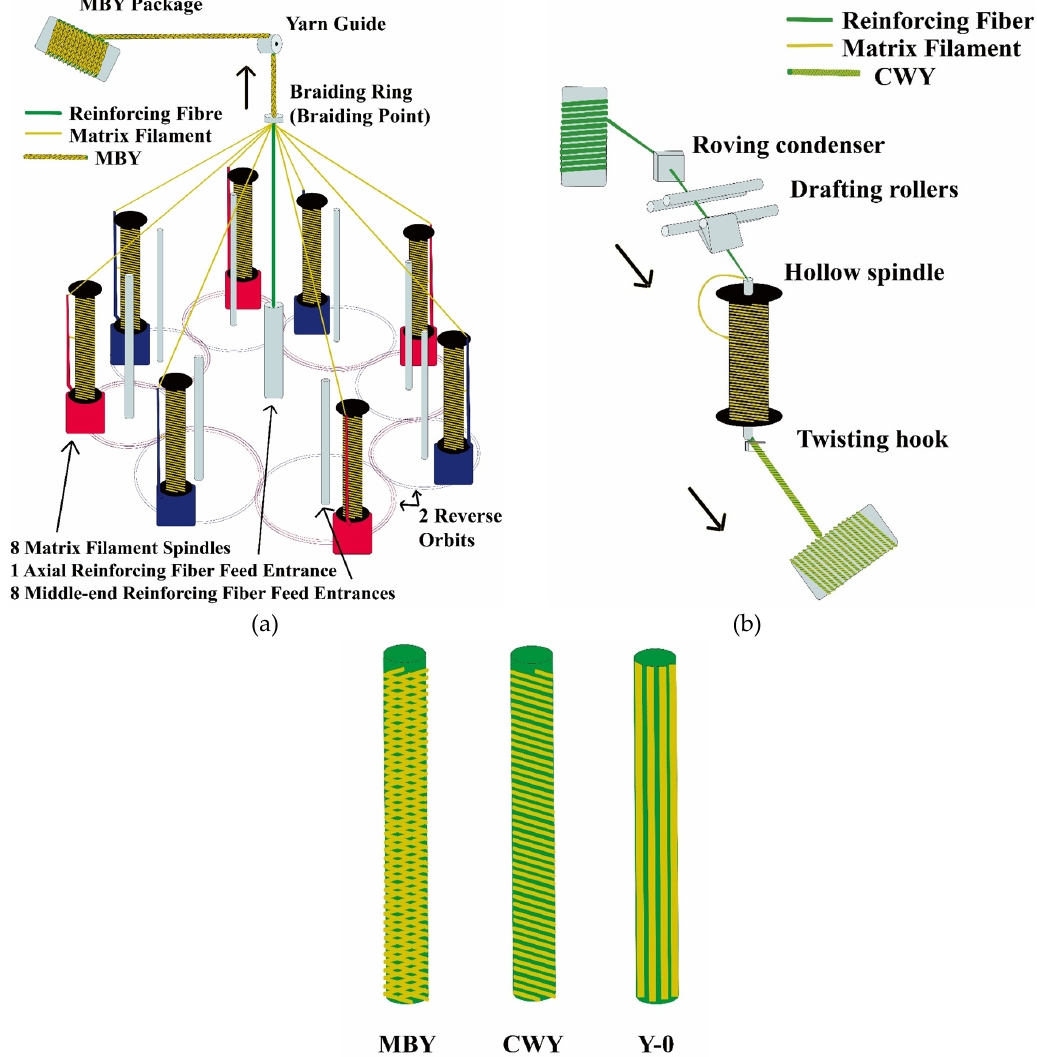
Figure 1. Schematic diagrams of manufacturing ( a ) micro-braided yarn (MBY) and ( b ) co-wrapped yarn (CWY). ( c ) Illustration of MBY, CWY and Y-0.